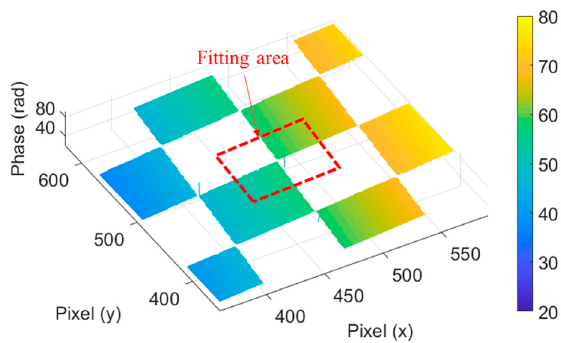
Figure 2. The fitting area at chessboard corners.